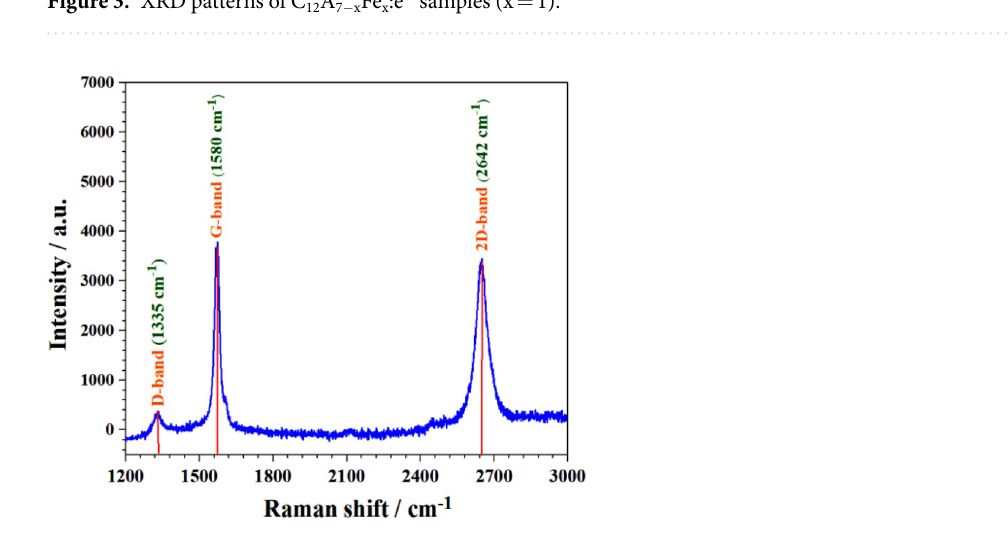
Figure 4. RAMAN spectra of C 12 A 7 − x Fe x :e − samples, where doping level, x =